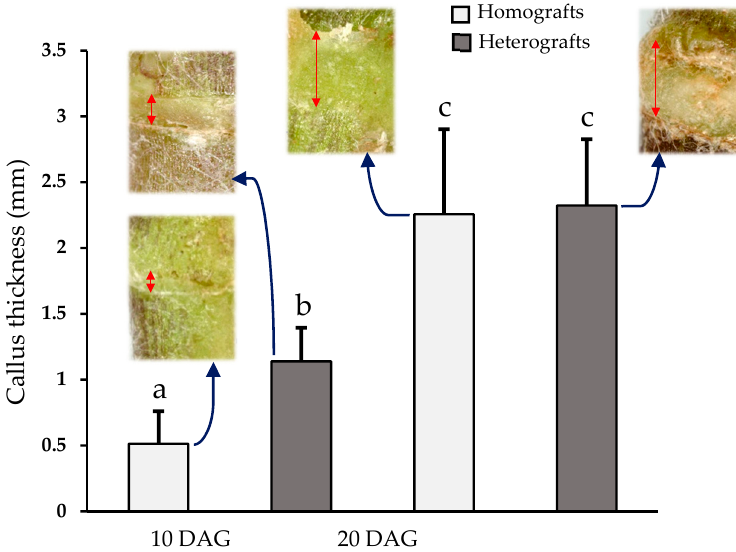
Figure 3. Callus thickness (mm) in homografts and heterografts at 10 and 20 days after grafting (DAG). Average and standard deviation are represented (N = 12). ANOVA variance analysis with Tukey pos ‐ hoc test was performed; equal letters indicates not significant differences ( p < 0.05).